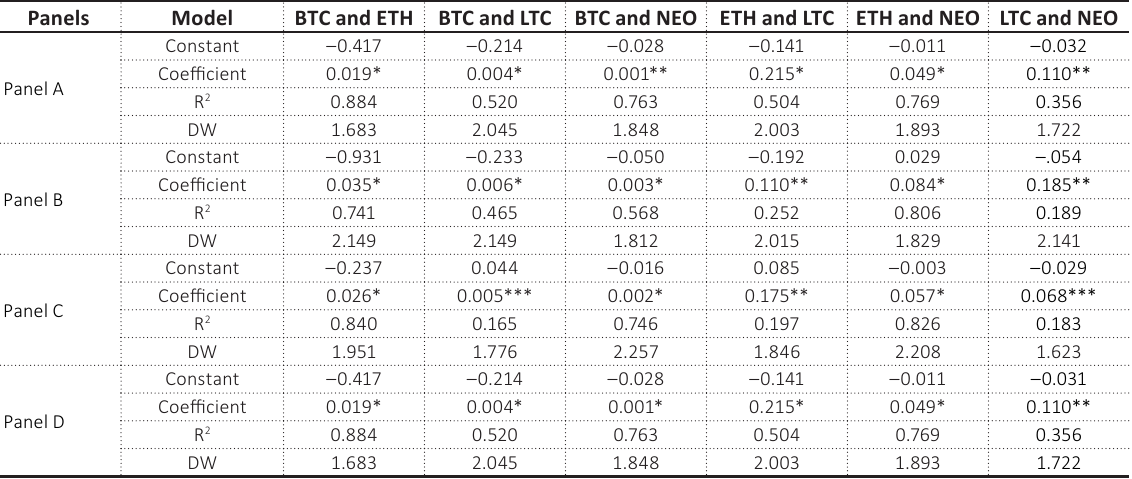
Table 4. Engle-Granger cointegration analysis of cryptocurrencies